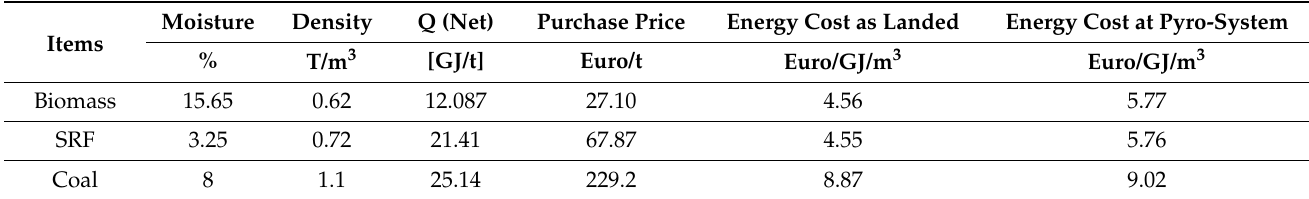
Table 7. Cement plant Fuels